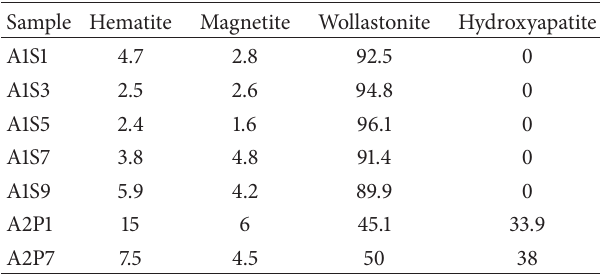
Table 3: The relative mass of the phases of the samples (wt%). Table 4: Chemical composition of the samples determined by SEM- EDS